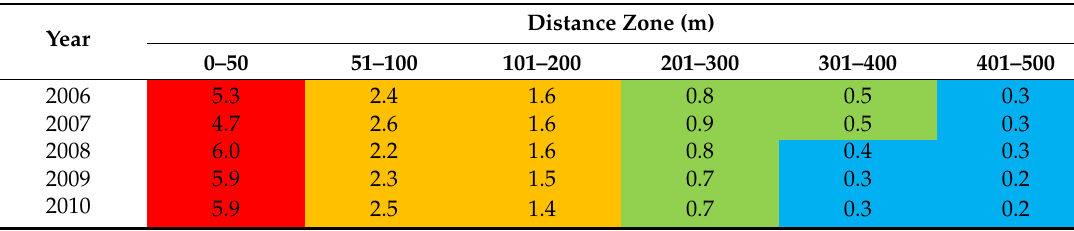
Table 8. LQC values of total crimes in all distance zones around alcohol outlets from 2006 to